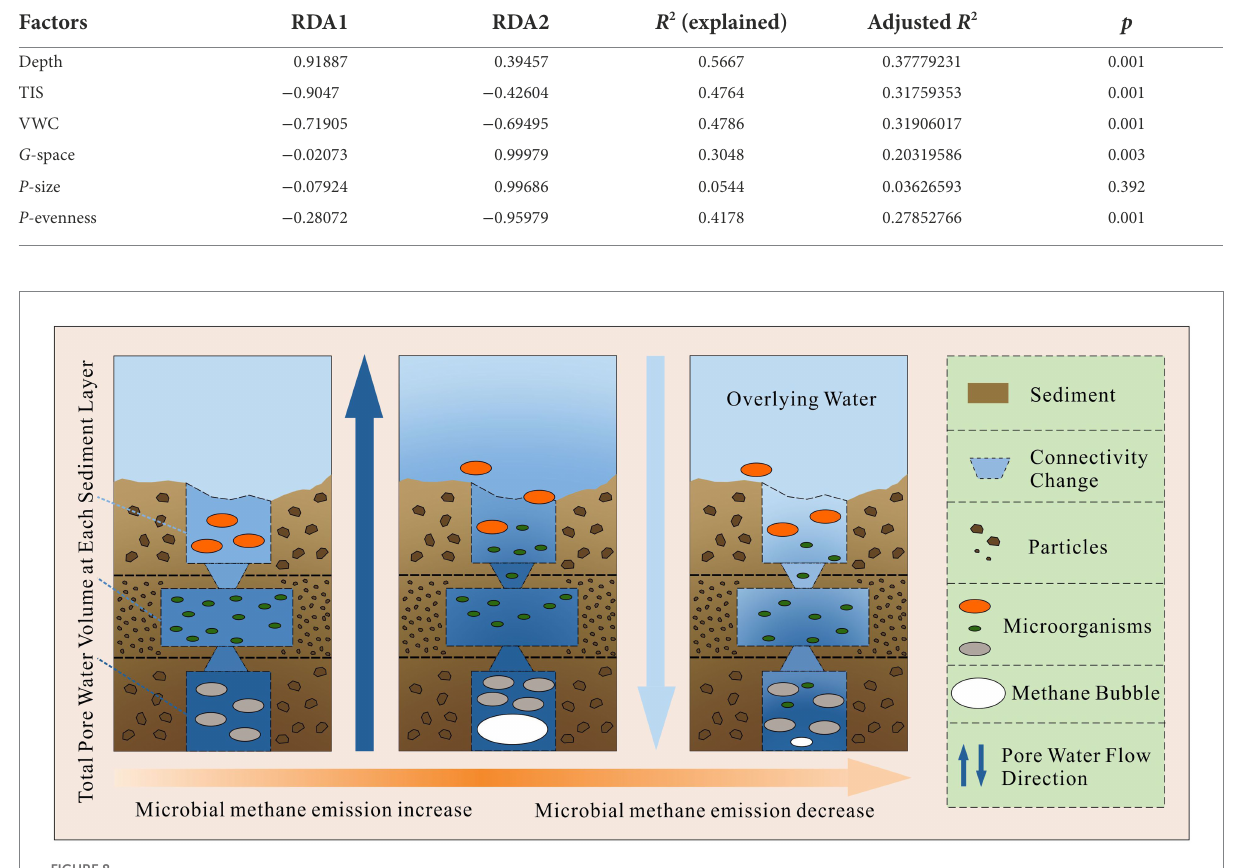
(Figure 4, main phyla: Proteobacteria, Acidobacteria, Chloroflexi,